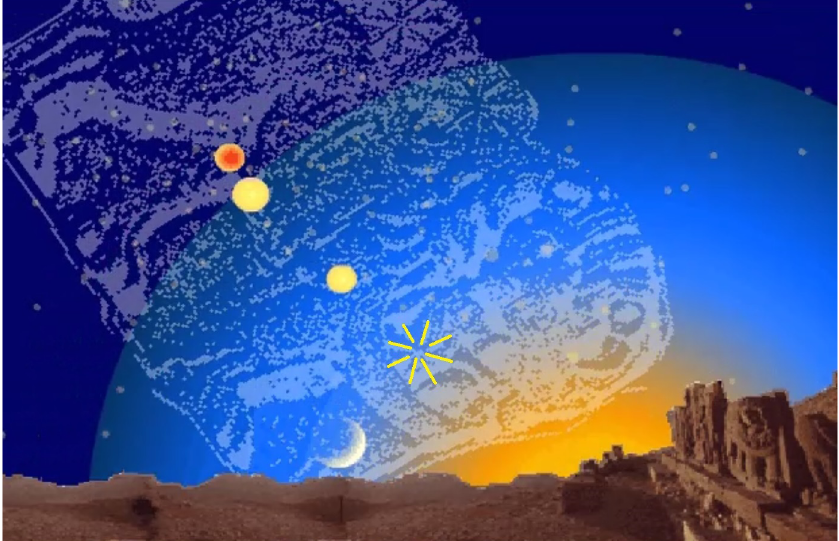
Fig. 6 Artist impression of the actual con fi guration. The con fi guration as seen at dusk from the West terrace of Mt. Nemrud on the 14th of July 109 BCE at 20:02 local time. Note the ensemble of fi ve steles at the right pointing to the celestial con fi guration in the west. Image by Maurice Crijns. This fi gure is not covered by the Creative Commons Attribution 4.0 International License. Reproduced with permission of Maurice Crijns; copyright © 2004 Crijns, all rights reserved.